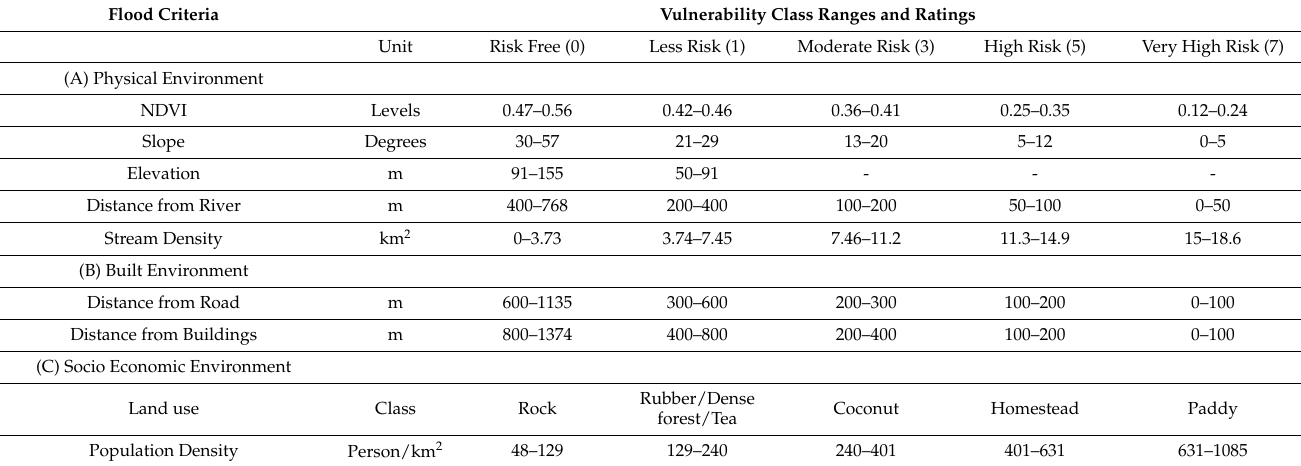
Table 3. Score values assigned to reclassify each sub-criterion map used for the